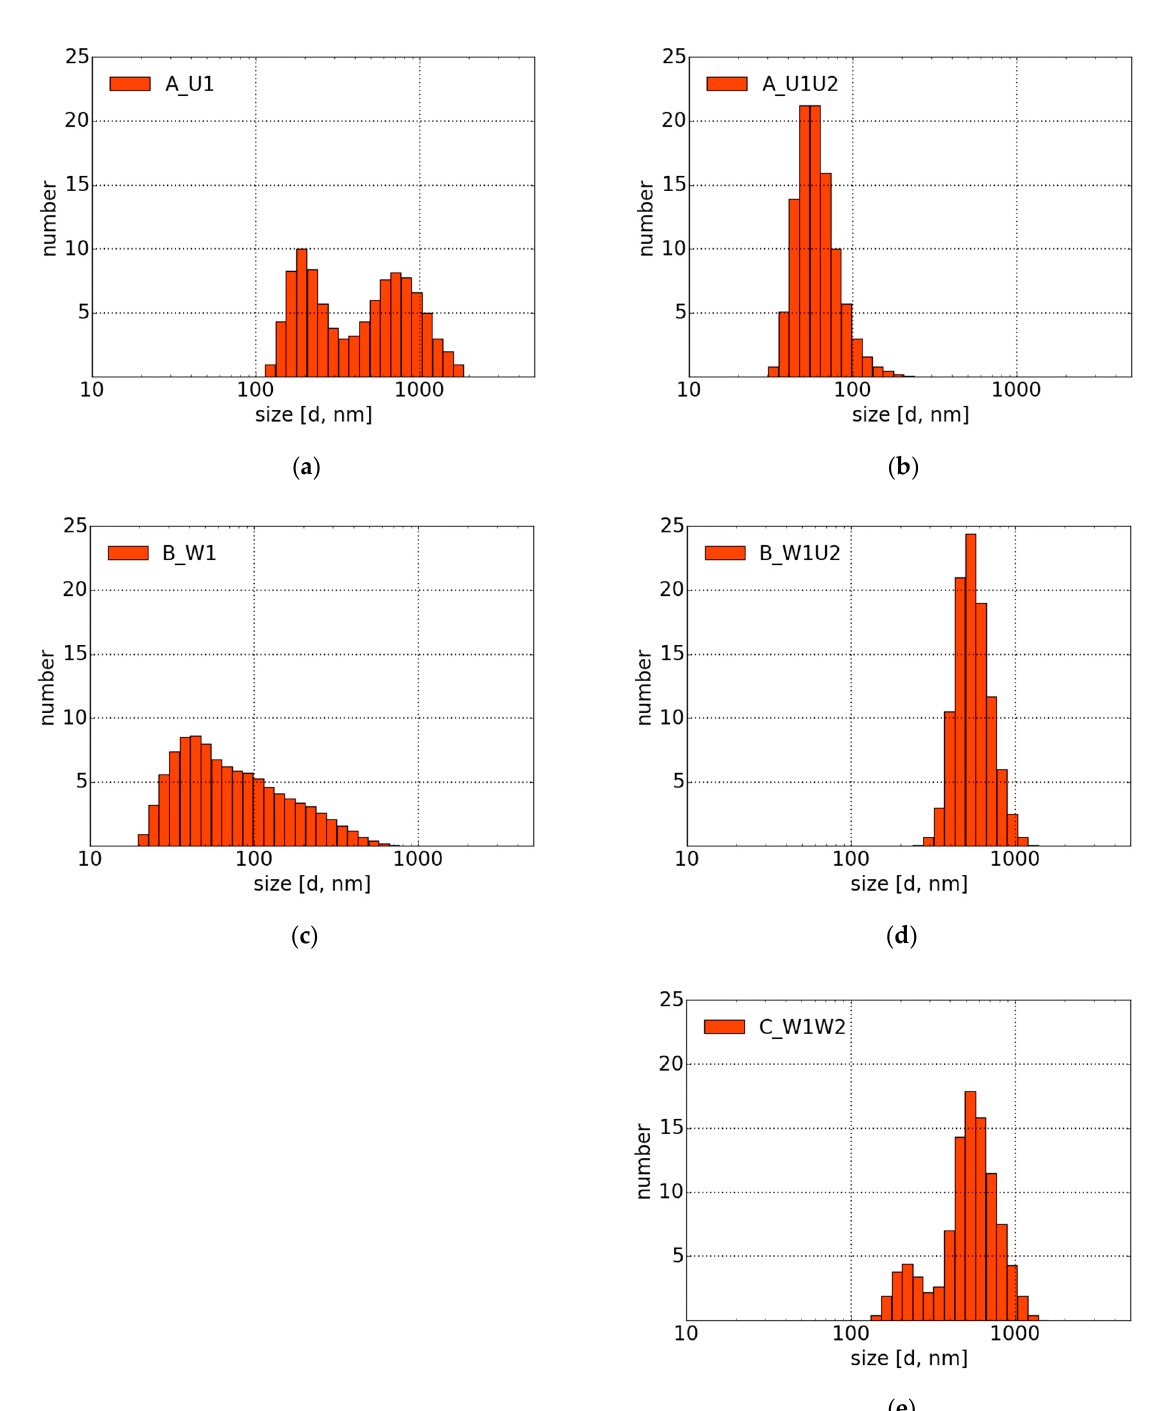
Figure 5. Size distributions of Samples ( a ) A_U1, ( b ) A_U1U2, ( c ) B_W1, ( d ) B_W1U2, and ( e ) C_W1W2. The mean standard deviation for all presented graphs was less than 9%.